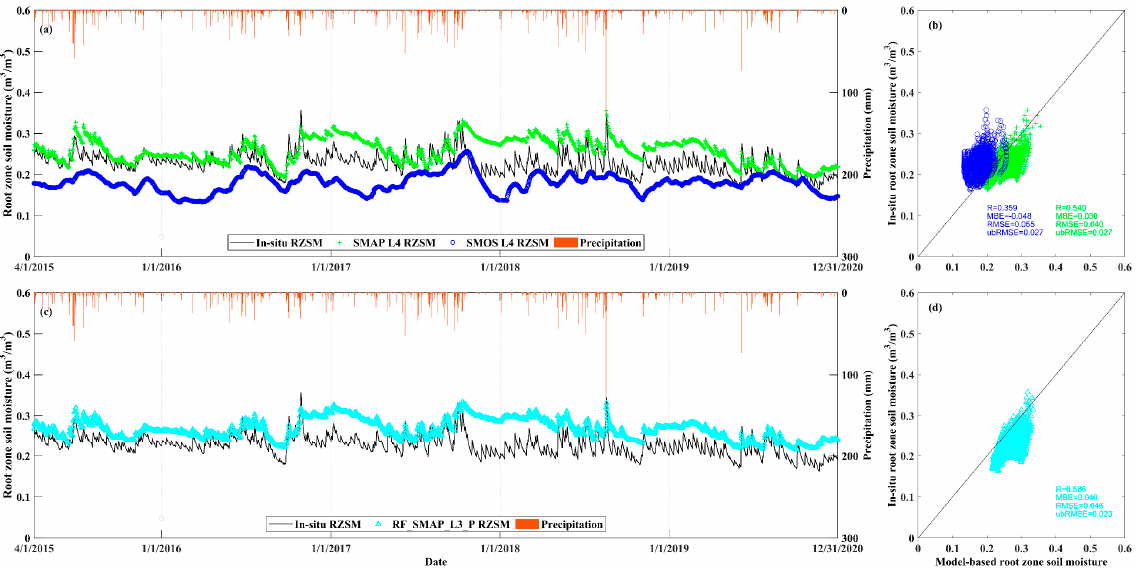
Figure 12. Same as Figure 9, but for the RZSM (0–100 cm). Left panel ( a , c ) shows the time series of in situ observations and RZSM model products. Right panel ( b , d ) shows the scatterplot.